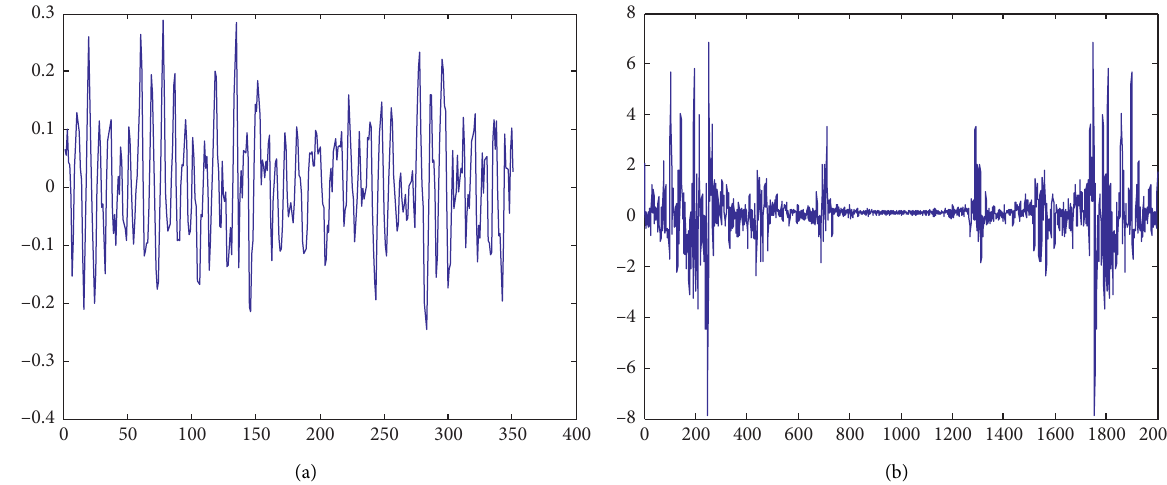
Figure 11: Partial time-domain data (a) and spectrum analysis (b) of fault